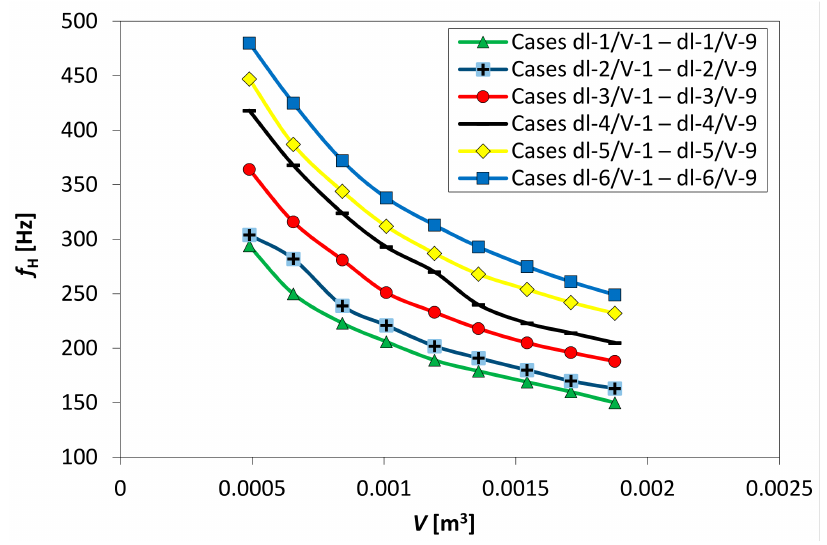
Figure 8. Effect of cavity volume and orifice diameter on the Helmholtz resonance frequency—the case of constant orifice